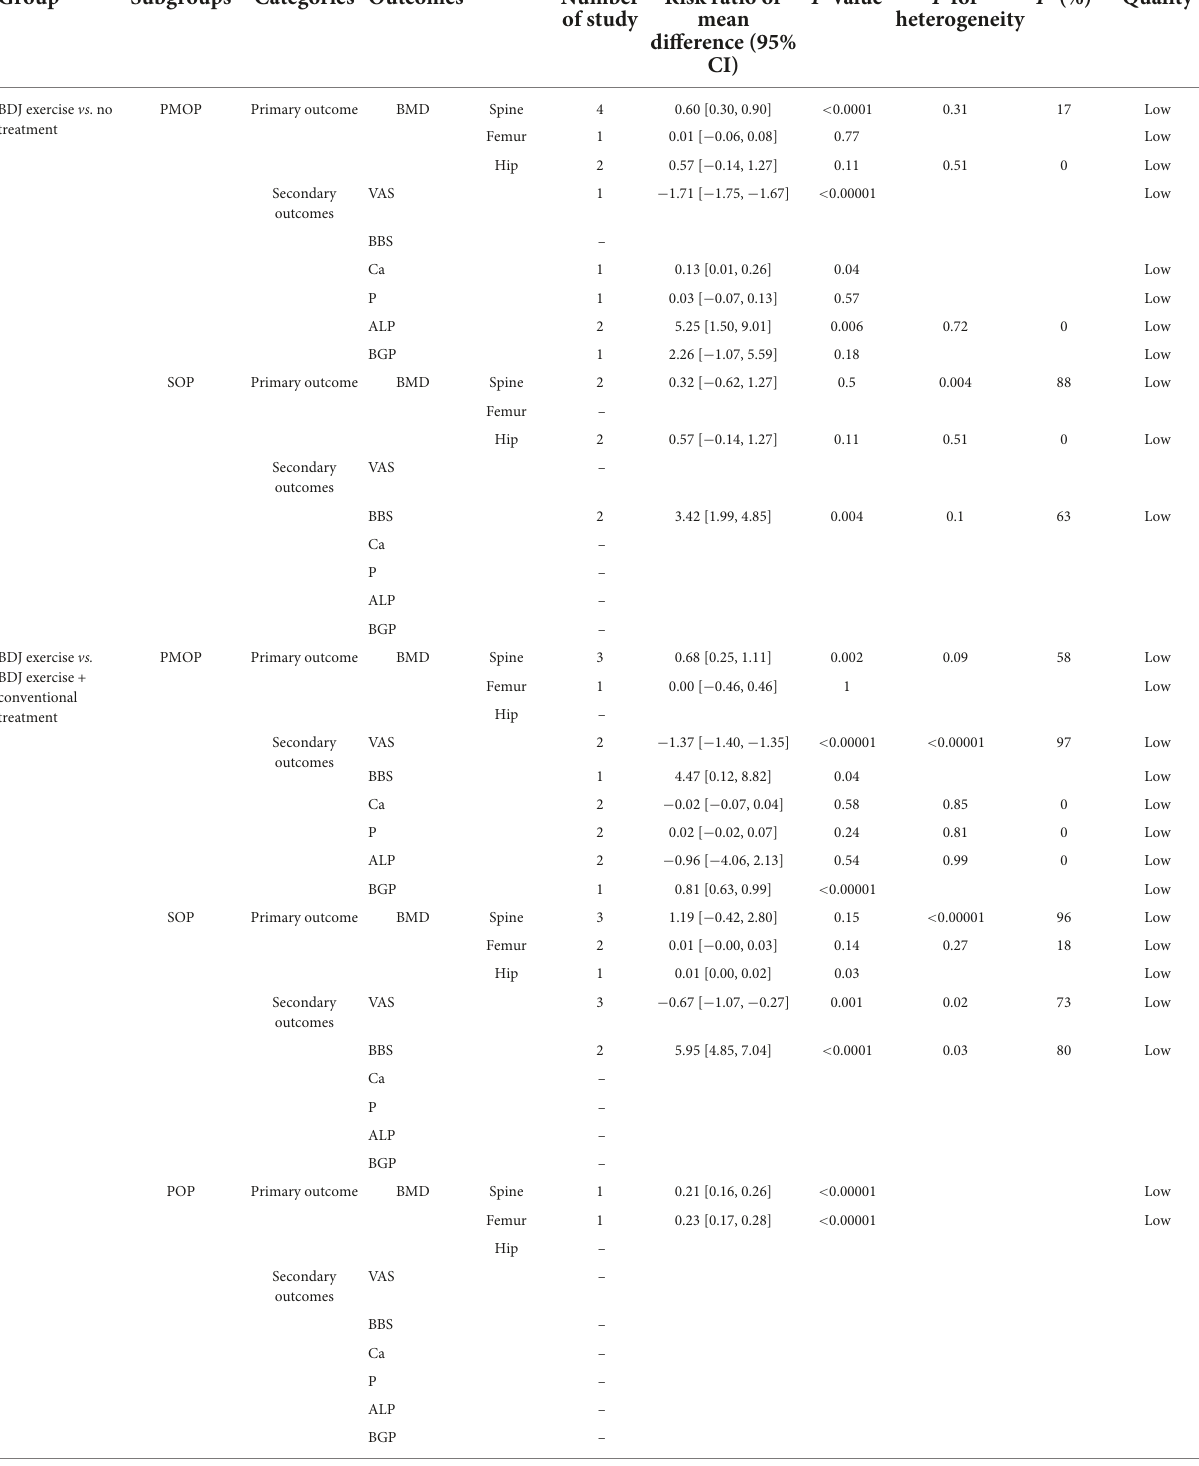
TABLE 3 The results of all outcomes for five subgroups: the control group vs. the intervention group. Group Subgroups Categories Outcomes Number